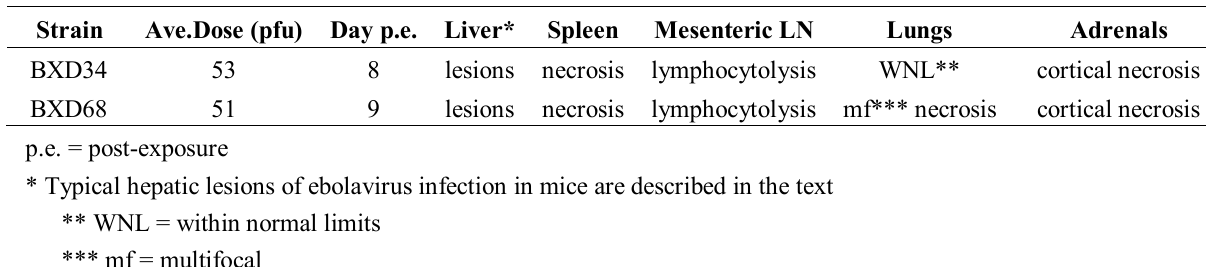
Table 2 . Summary of significant histopathologic